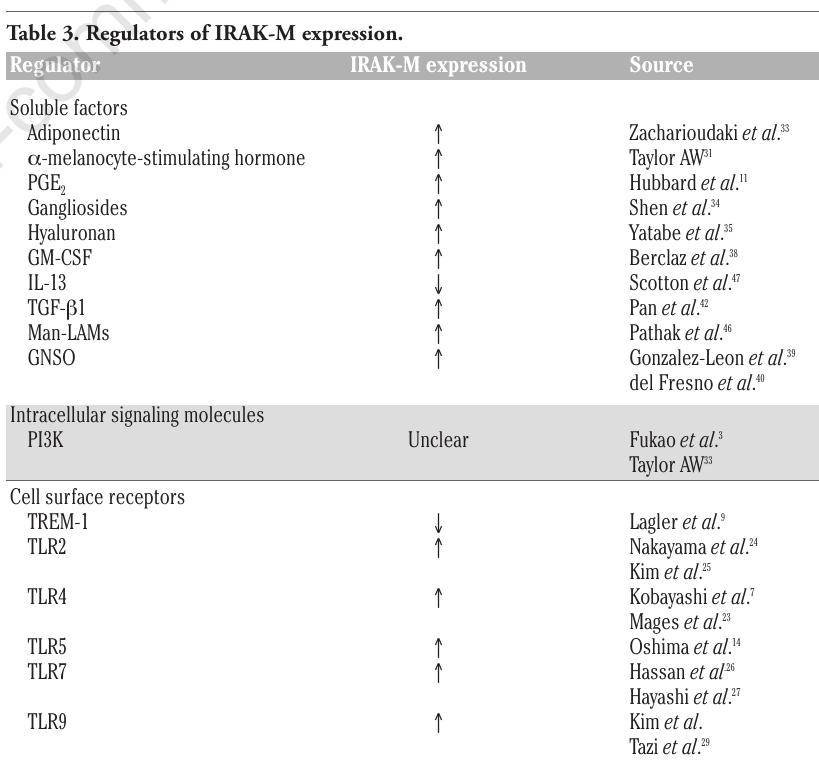
Table 3. Regulators of IRAK-M expression.